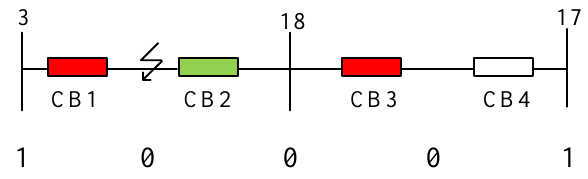
Figure 11. Fault area and breaker state diagram.